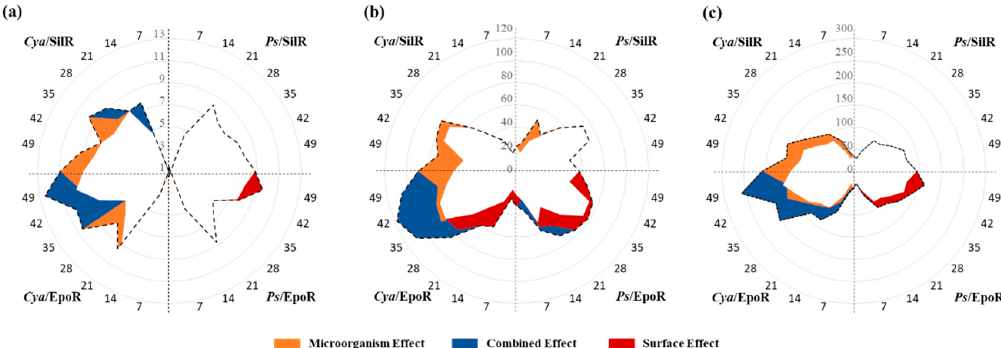
Figure 3. Radar charts representing ( a ) the number of cells (10 8 cells / cm 2 ), ( b ) wet weight (mg), and ( c ) thickness ( µ m) for Pseudoalteromonas tunicata ( Ps , right side) and Cyanobium sp. LEGE 10375 ( Cya , left side) biofilms developed on SilRef (upperside) and EpoRef (downside) surfaces. Average values (previously represented in Figure 2) are plotted as a dashed line considering the time scale (days) indicated in each quadrant. The following conditions are depicted in each quadrant: Ps / SilR (top right quadrant), P. tunicata on SilRef; Ps / EpoR (bottom right quadrant), P. tunicata on EpoRef; Cya / EpoR (bottom left quadrant), Cyanobium sp. on EpoRef; Cya / SilR (bottom right quadrant), Cyanobium sp. on SilRef. Colored areas represent the microorganism or surface e ff ect, which are equivalent to all positive di ff erences observed in each parameter (biofilm cell number, wet weight, and thickness), when subtracting the results obtained at the same microorganism (surface e ff ect) or with the same surface (microorganism e ff ect). Overlap areas are also highlighted, indicating a combined e ff ect of the microorganism and surface.